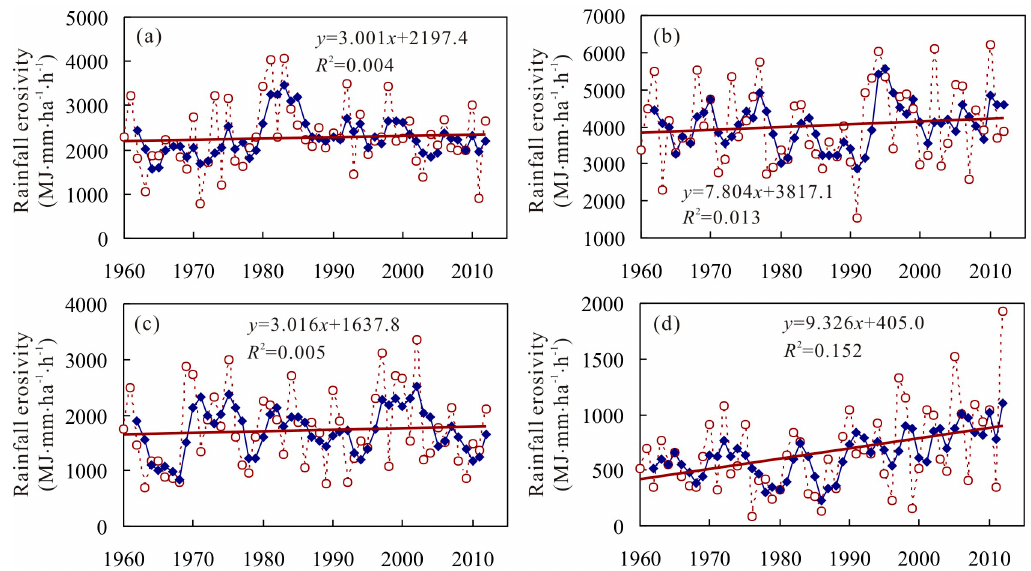
Figure 5. Variation of seasonal rainfall erosivity for ( a ) spring, ( b ) summer, ( c ) autumn, and ( d ) winter during the period of 1960–2012. Table 2. Results of the M-K test for seasonal and annual RE and annual erosivity density (ED). Spring Summer Autumn Winter Annual RE Annual ED M-K statistic 0.64